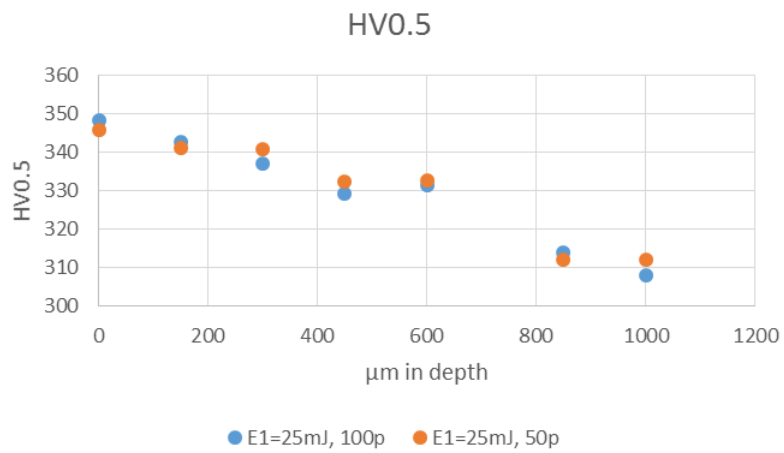
Figure 13. The microhardness measurments in depth of LSP areas treated by laser energy E 1 = 25 mJ and number of pulses 50 and 100, at wavelength 532 nm.